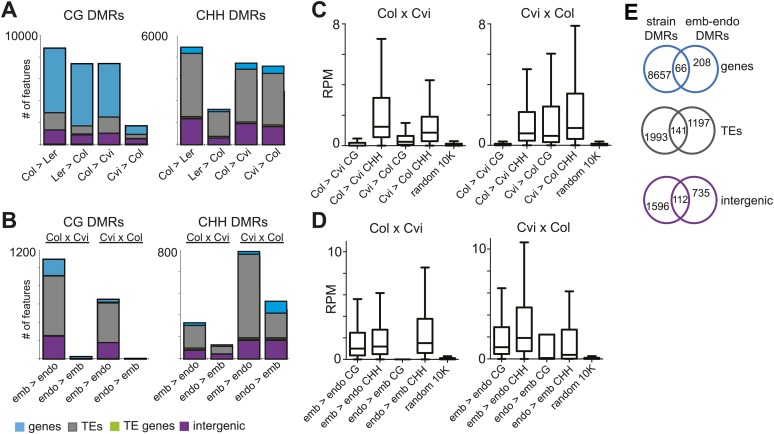
Strain DMRs and embryo-endosperm DMRs are in distinct genomic regions.(A) Number of features overlapping strain DMRs between Col and Ler or Col and Cvi embryos. (B) Number of features overlapping embryo-endosperm DMRs in Col x Cvi and Cvi x Col crosses. (C and D) 24 nt small RNA quantities (reads per million) corresponding to Col-Cvi strain (C) and Col x Cvi or Cvi x Col embryo-endosperm DMRs (D). (E) Overlap between Col-Cvi strain positive CG DMRs (more methylated in Col than Cvi) and the union of Col x Cvi and Cvi x Col embryo-endosperm CG DMRs (embryo more methylated than endosperm) corresponding to genes, TEs, and intergenic regions. Figure 4—figure supplement 1 show the distribution of all methylation differences; Figure 4—figure supplement 2 shows DMR analysis in Ler-Cvi crosses and other datasets; Figure 4—figure supplement 3 validates DMRs identified in this analysis; Figure 4—figure supplement 4 examines small RNAs at TEs and Figure 4—figure supplement 5 shows the overlap of embryo-endosperm CpG DMRs with previous studies. sRNA-seq library metrics are in Figure 4—source data 1.DOI:
http://dx.doi.org/10.7554/eLife.03198.02310.7554/eLife.03198.024Figure 4—source data 1.Whole seed sRNA-seq libraries generated in this study.